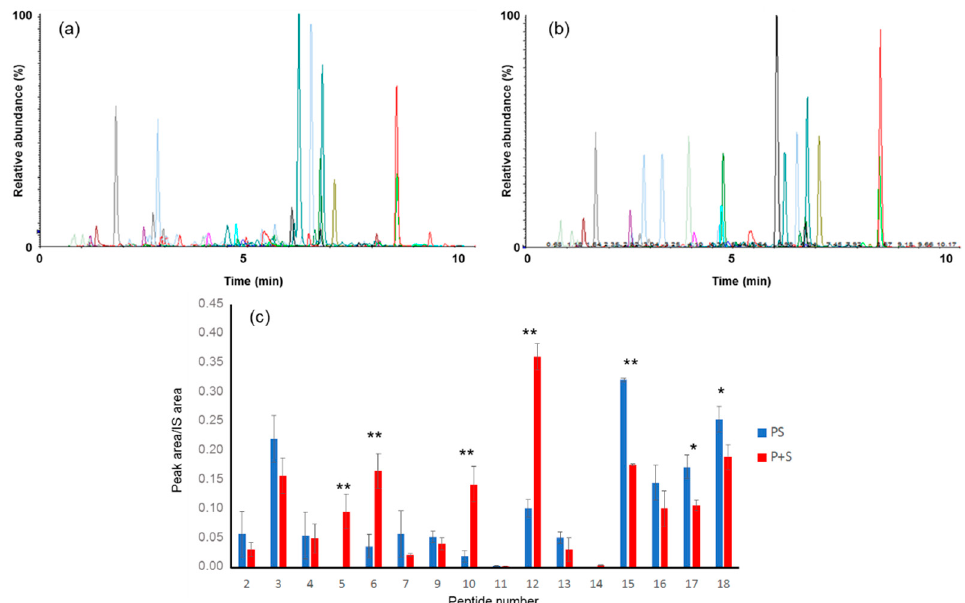
Figure 4. XIC obtained by the analysis of PS ( a ) and P+S ( b ) subjected to simulated gastro-intestinal digestion. The experiment was performed in triplicate ( n = 3) and the average area measured for each peptide in the two samples were compared ( c ). * p ≤ 0.05 and ** p ≤ 0.01 indicate a significant difference between the peptide abundance in PS and P+S samples.